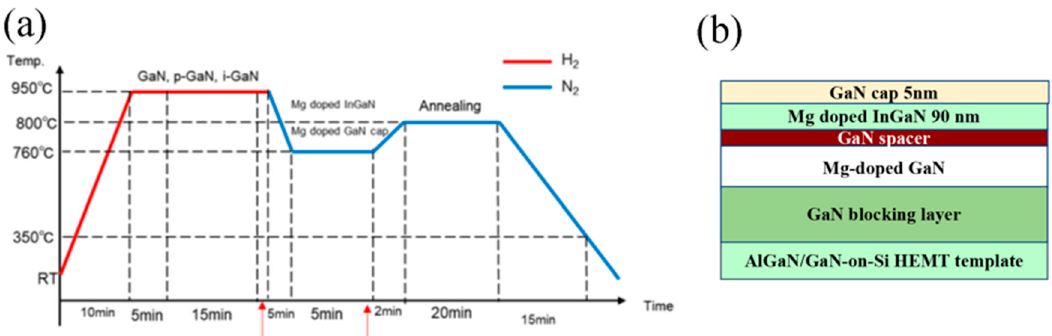
Figure 1. ( a ) Schematic diagram for the deposition process of the InGaN/GaN heterostructures, and ( b ) structure of the InGaN/GaN heterostructure on the AlGaN/GaN-on-Si high electron mobility transistor (HEMT)